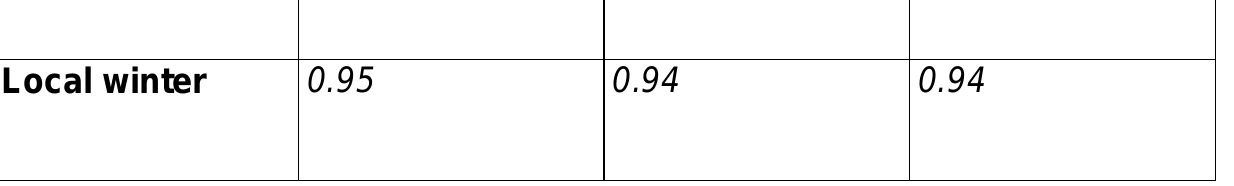
Table 1: Correlation coefficient between H, D and Z daily excursions with the K p